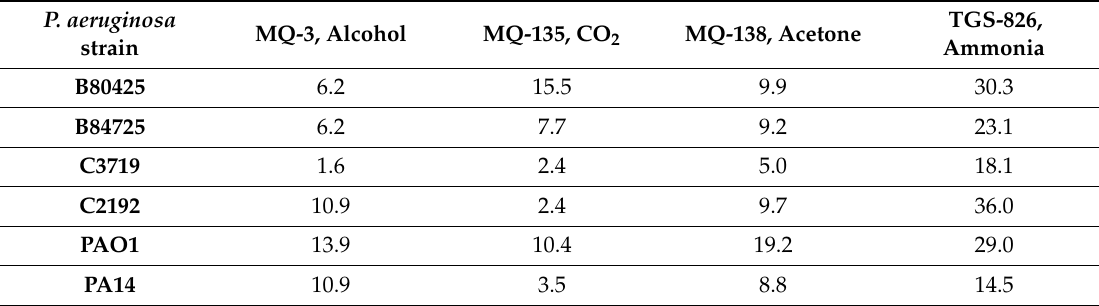
Table A4. Mean values of the P. aeruginosa liquid samples at 2.5 mm.